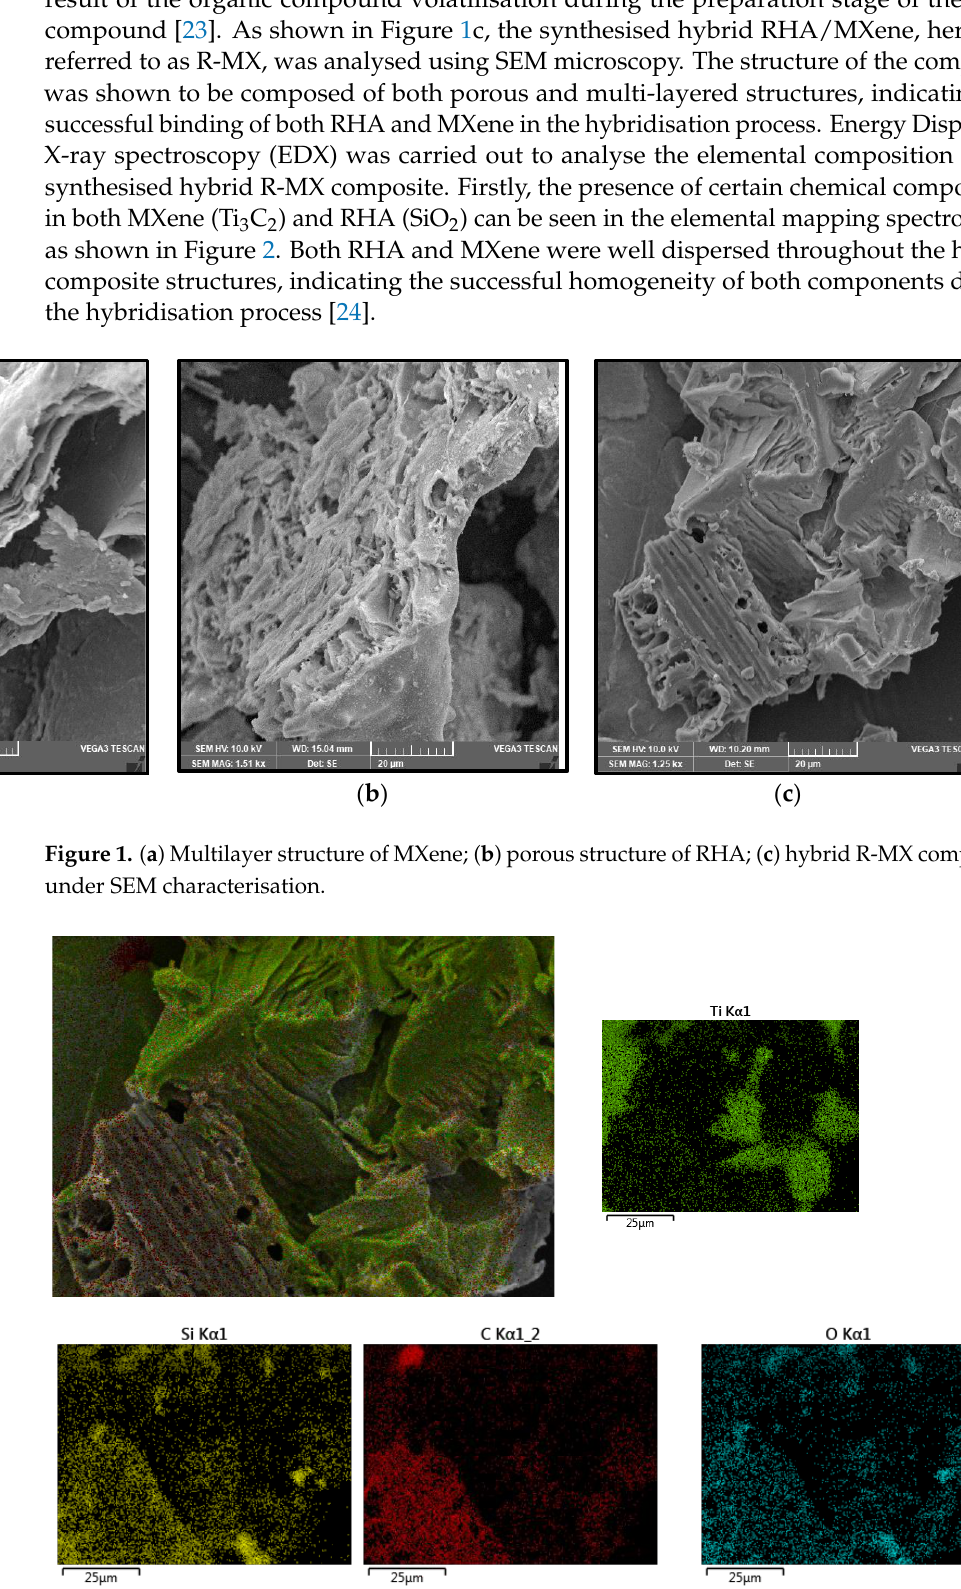
Figure 2. EDX elemental mapping of the R-MX composite.